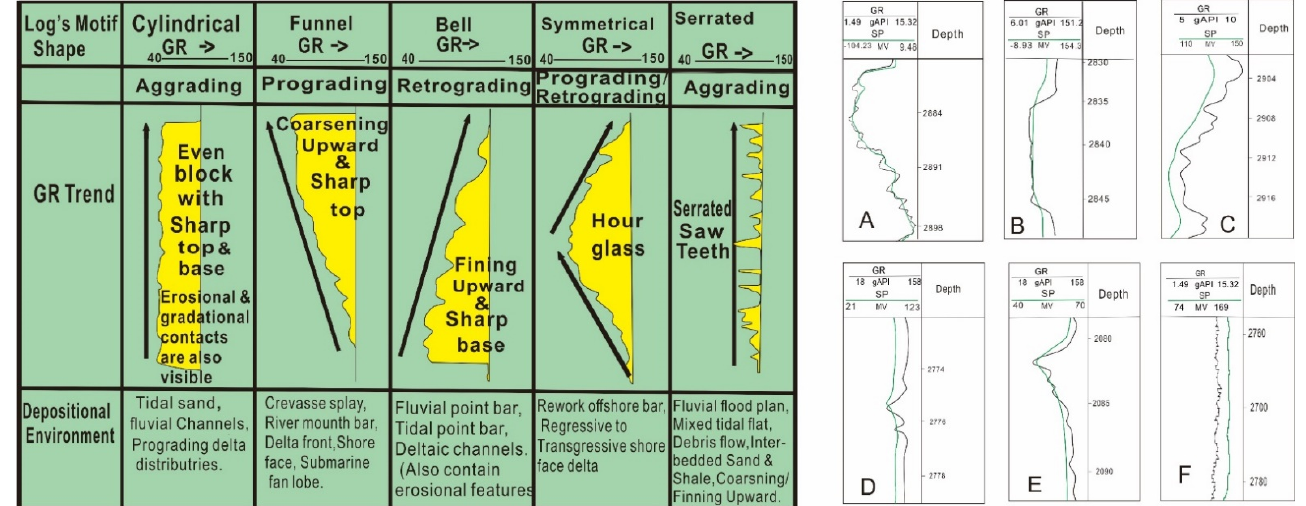
Figure 3. Modified typical trends of gamma ray log shapes at left after Selley and Nazir [19,20], Demonstration of typical logs from study area ( A ) High amplitude funnel-shaped to interpret mouth bars, ( B ) Box-shaped trend to interpret distributary channel, ( C ) Bell-shaped curve for identrifying the distributary channel, ( D ) Finger or serrated shaped curve to identify the sand sheet, ( E ) Low amplitude funnel-shaped to recognize the natural levee, ( F ) High amplitude curve to interpret the interdistributary mudstone [18]. Table 1. Representative cores to study lithological characteristics and facies analysis.